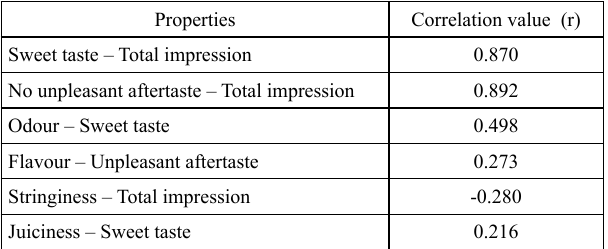
Table 4. Correlation between the properties by the mean of hybrids